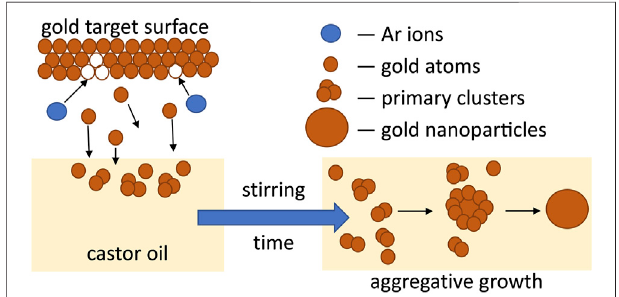
FIGURE 7 | Scheme of the formation of Au NPs after magnetron sputtering of gold target onto castor oil.